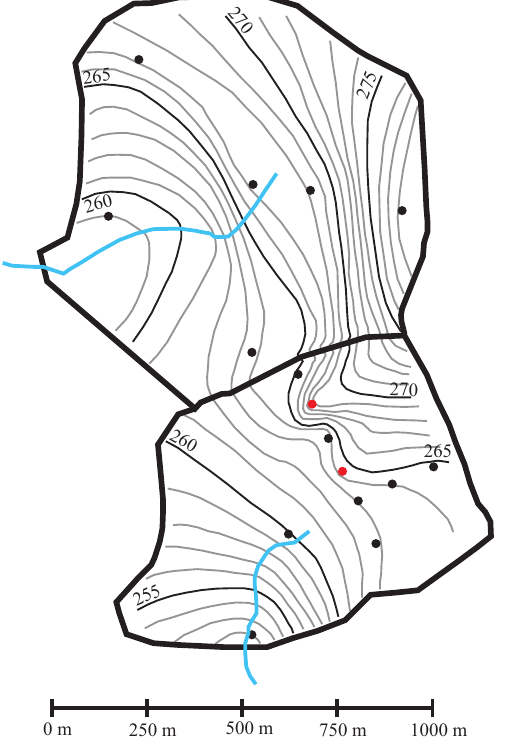
Figure 8. Groundwater potentiometric surface map for September 2012. Note the northeast corner of the farm catchment where the fracture flow evident in bores 2279 and 2277 (red dots) exhibit preferential pathways in the equipotential lines. See Fig. 1 for location.